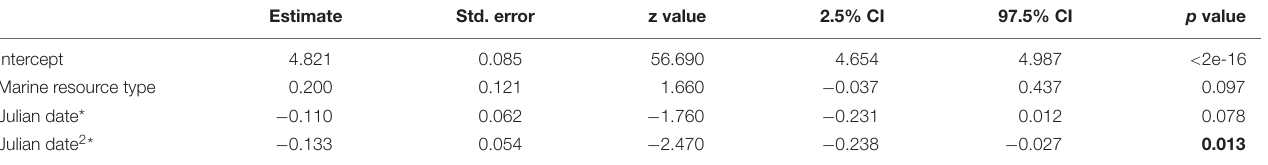
TABLE 1 | GLMM output with peck rate as dependent variable and food resource type, Julian date and quadratic effect of Julian date as independent variables.